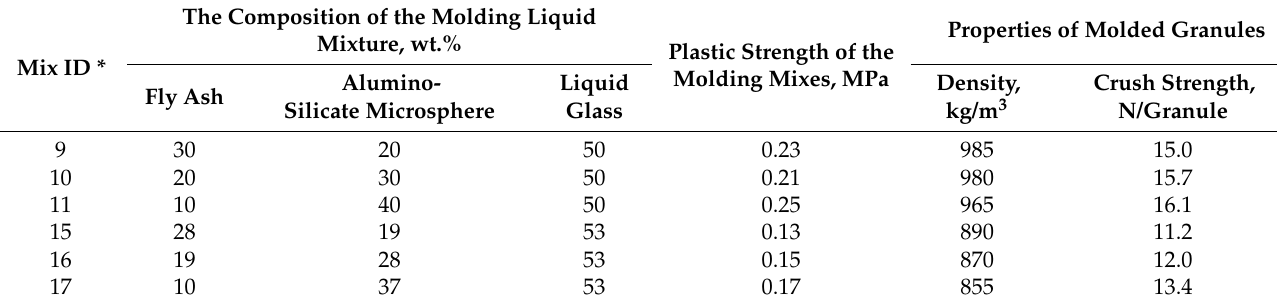
Table 4. Composition and properties of molded